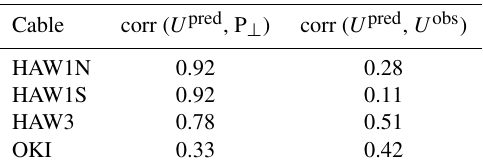
Figure 6. The results for the HAW3 cable. The cable orientation is from California to Hawaii. The description corresponds to Fig. 4. Table 2. For individual seafloor cables, we show the correlation coefficients between the cable voltages predicted by the numerical model and the total ECCO-derived water transport across the cable P ⊥ in the second column. The third column shows the correlation coefficients between the predicted and observed voltages for 30.5d spline knot